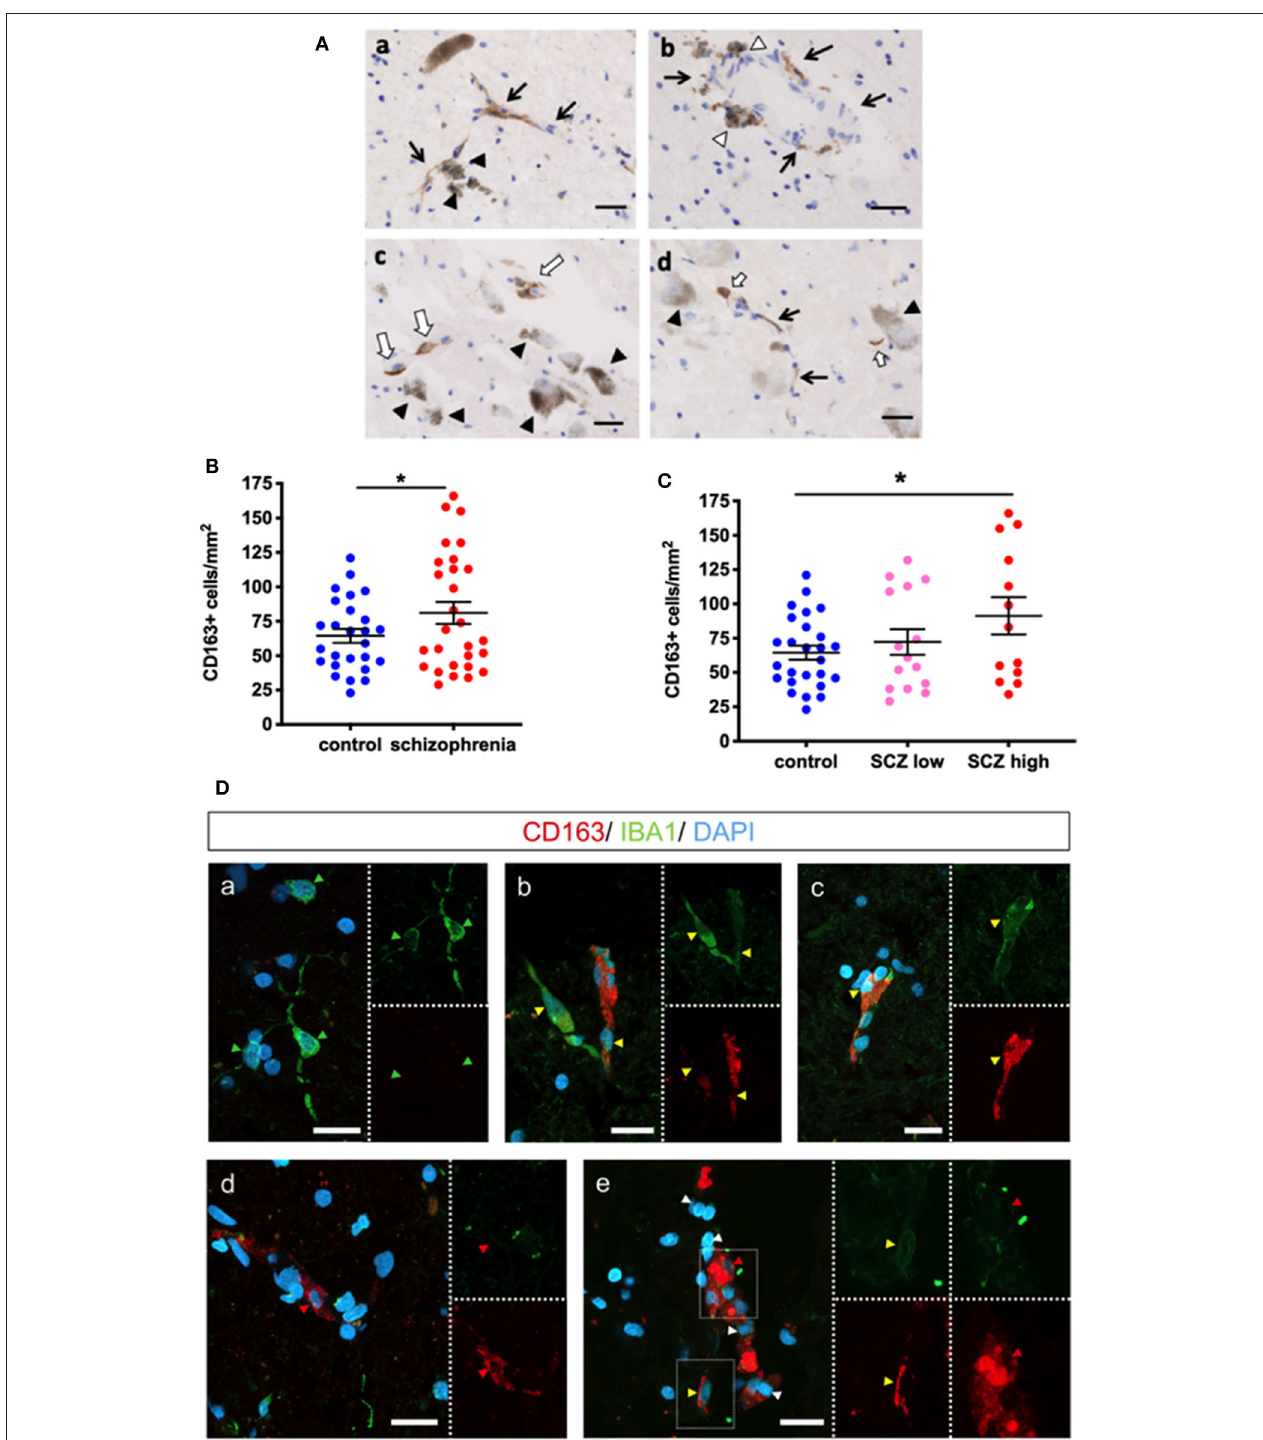
FIGURE 3 | CD163 immunoreactive cells are in the parenchyma and in close proximity to dopamine neurons in the substantia nigra. (A) Dopaminergic neurons are identified by dark brown neuromelanin (black triangles). Black arrows indicate blood vessels. (a) CD163 + cells associated with blood vessels are in close proximity to dopaminergic neurons. (b) CD163 + cells are observed on the parenchymal side of blood vessels (white triangle). (c,d) CD163 + cells not associated with vessels (white arrows) are in close proximity to dopaminergic neurons (black triangle). Scale bar = 20 µ m. (B) The number of CD163 + cells was increased when analyzed by diagnosis ( t = 1.71, df = 52, p = 0.047) and (C) was increased in the high inflammatory/schizophrenia group by planned post-hoc comparison ( p = 0.030). (D) IBA1